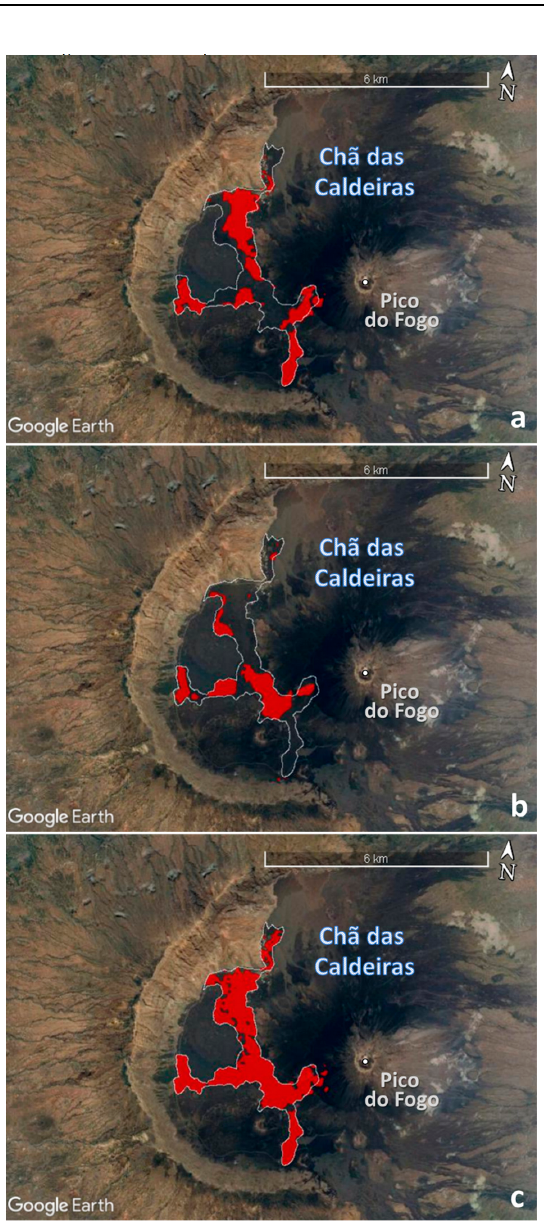
Figure 6. Classifiers outcomes for the 2014–2015 Fogo eruption. ( a ) K-mean outcome for the S1 data; ( b ) SVM outcome for the L8 data; ( c ) SVM outcome for the fused data. Chã das Caldeiras is the summit caldera, inside which the active cone of Pico do Fogo rises up. This figure was generated using Google Earth.